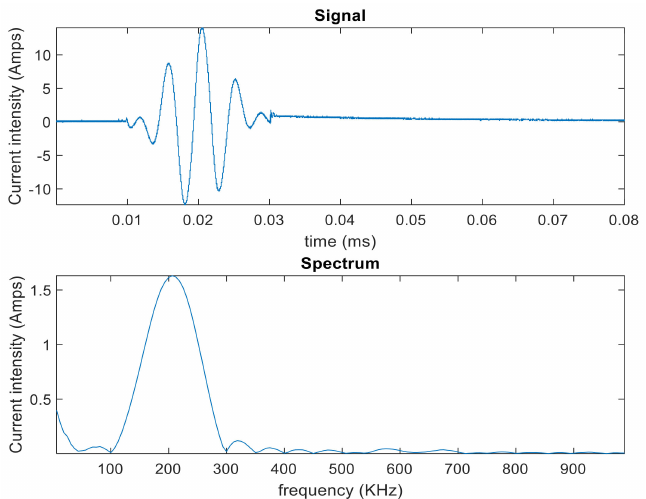
Figure 6. Experimental apparatus used for studying guided wave generation.